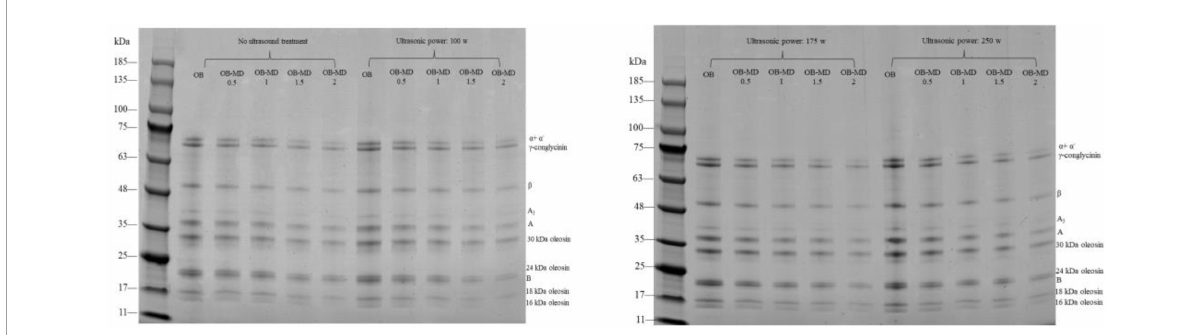
FIGURE5 SDS-PAGE pattern of surface proteins in microencapsulated soybean